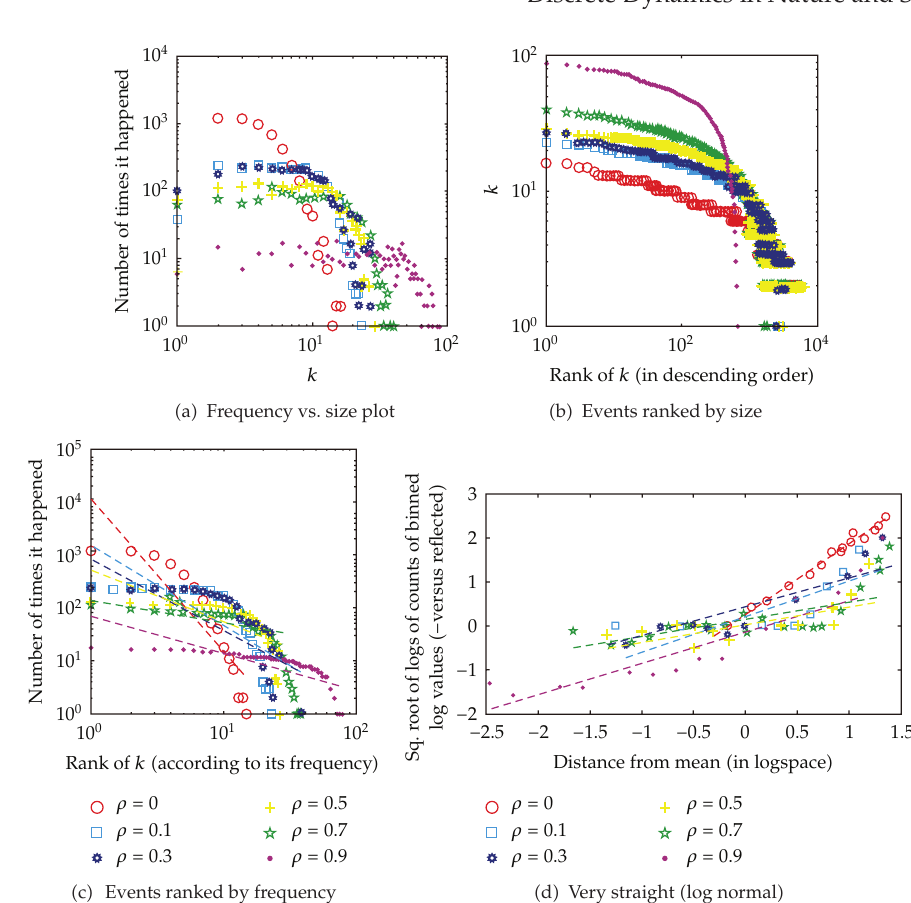
Figure 2: Histograms of event frequency versus size, event rank versus size, event rank versus frequency and the log-normal behavior test of the node degree of networks generated with the proposed evolving model with m (cid:8) 4 versus di ff erent